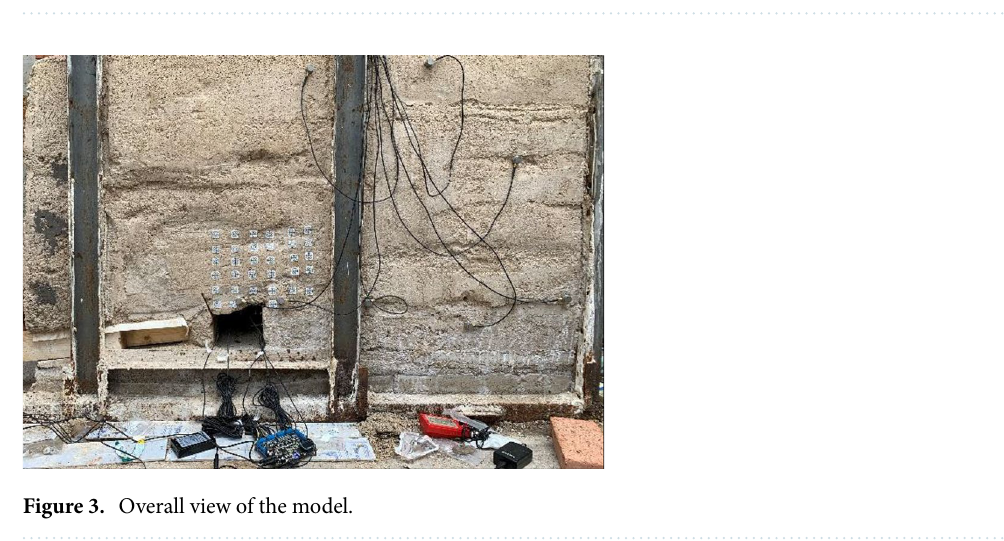
Table 1. Proportioning of Materials for Similar Material Models.